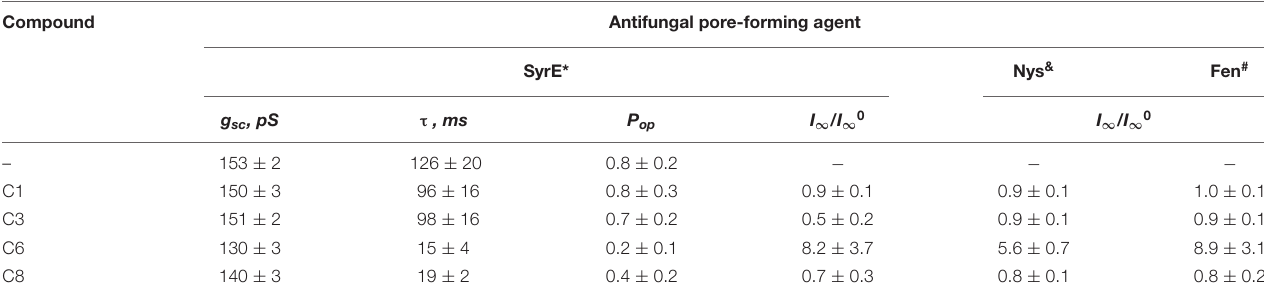
g SC , conductance of single channels in the absence and presence of the compound at V = − 200 mV; τ , dwell time of single pores; I ∞ /I ∞ 0 , ratio of the transmembrane current induced by the antifungal in the presence and absence of modifier at V = 50 mV. The lipid bilayers were composed of DPhPC (*), DPhPC/CHOL ( & ), and POPC/POPE/POPG/ERG ( #